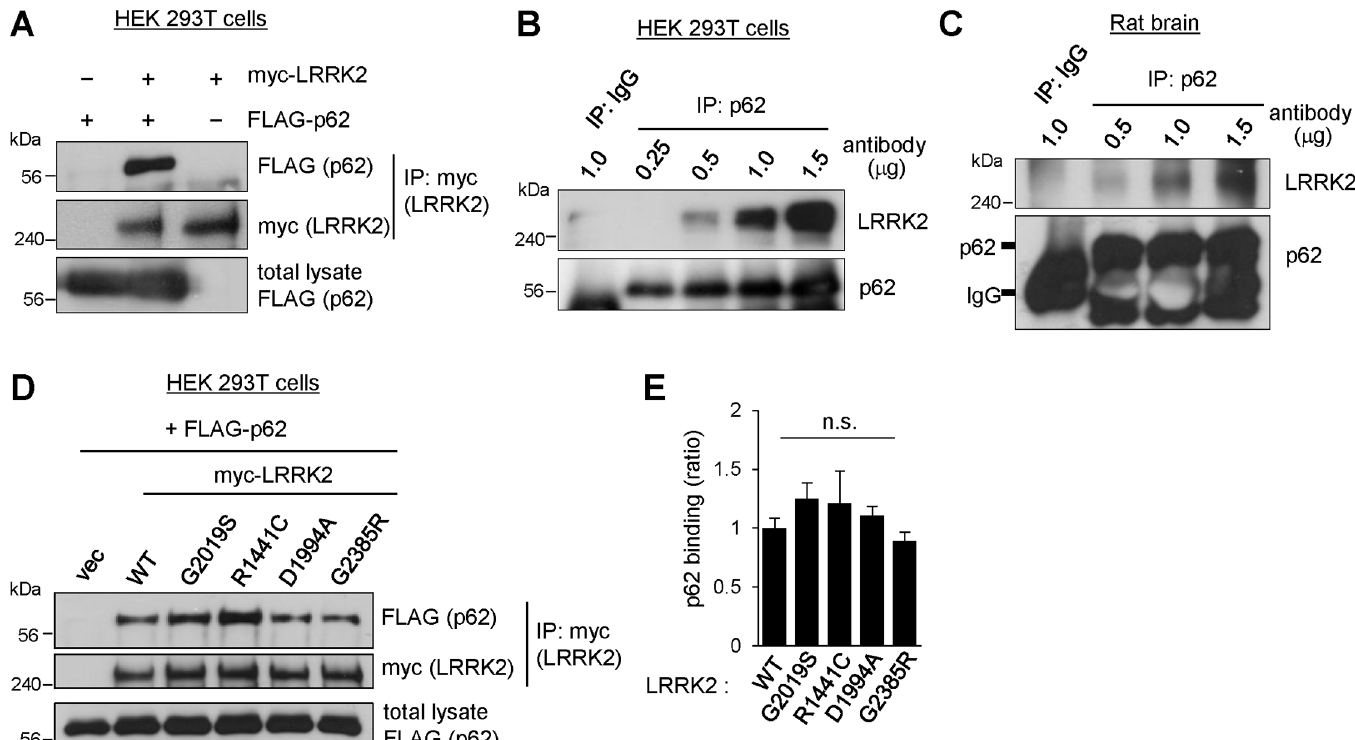
Fig 2. LRRK2 interacts with p62. A . HEK 293T cells were transiently co-transfected with FLAG-tagged p62 (FLAG-p62), c-myc-tagged LRRK2 (myc- LRRK2), or both. Twenty-four hours after transfection, total cell lysates were subjected to immunoprecipitation with anti-c-myc monoclonal antibody 9E10. Binding of p62 to LRRK2 was analyzed with western blotting. B . Binding of endogenous LRRK2 to p62 was examined in HEK 293T cells via immunoprecipitation with the indicated quantities of anti-p62 antibody (0.25~1.5 μ g). C . The P2 fraction of total rat brain lysate was subjected to immunoprecipitation with the indicated quantities of anti-p62 antibody (0.5~1.5 μ g). Immune complexes were resolved by SDS-PAGE, followed by western blotting against the indicated antibodies. One microgram of rabbit anti-GFP antibody was used as a negative control (IgG). D . HEK 293T cells were transiently transfected with myc-tagged LRRK2 WT or mutant expression constructs (G2019S, R1441C, D1994A, or G2385R) and FLAG-tagged p62. Co- immunoprecipitation was performed as shown in panel A. E . Bar graph shows the relative binding of p62 to mutant LRRK2, normalized to LRRK2 WT. The data were obtained from four independent experiments; n.s. indicates p > 0.05 versus WT binding, analyzed with one-way ANOVA.